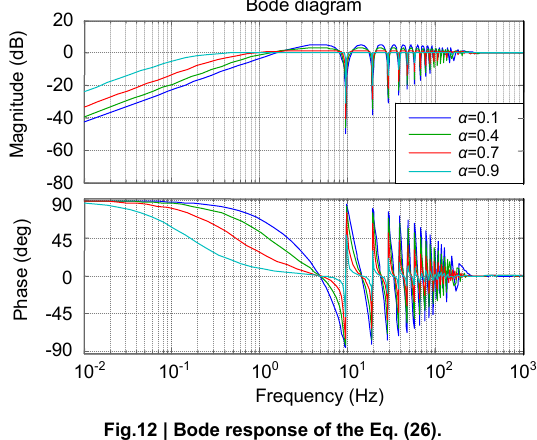
Fig.12 | Bode response of the Eq. (26).